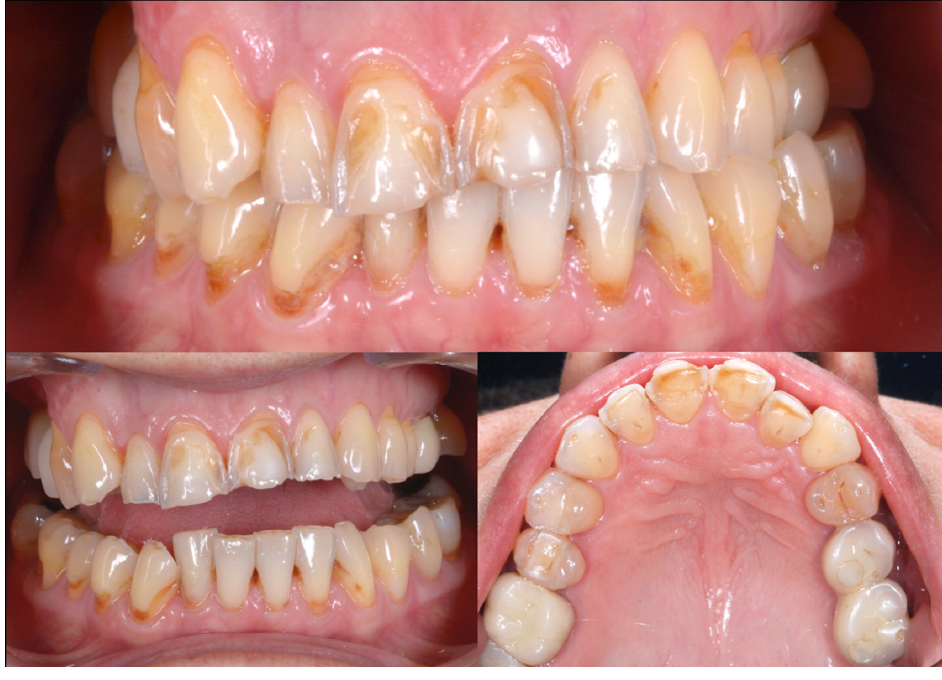
Figure 1. Intra-oral photos showing the extensive erosion of the frontal teeth.